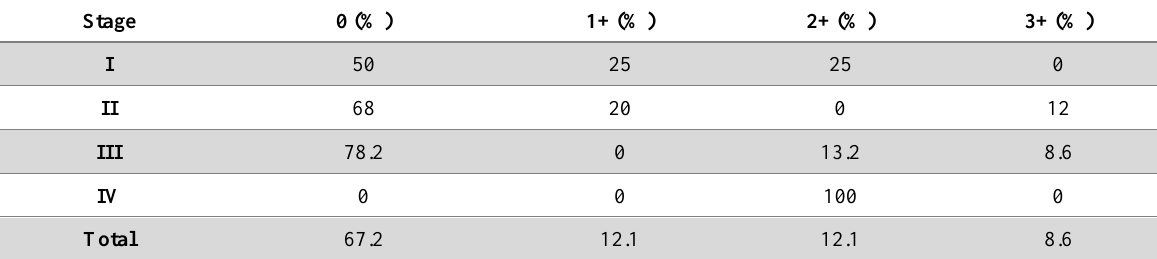
Table 4. Comparison of Bcl-2 expression and its prognostic value in various studies